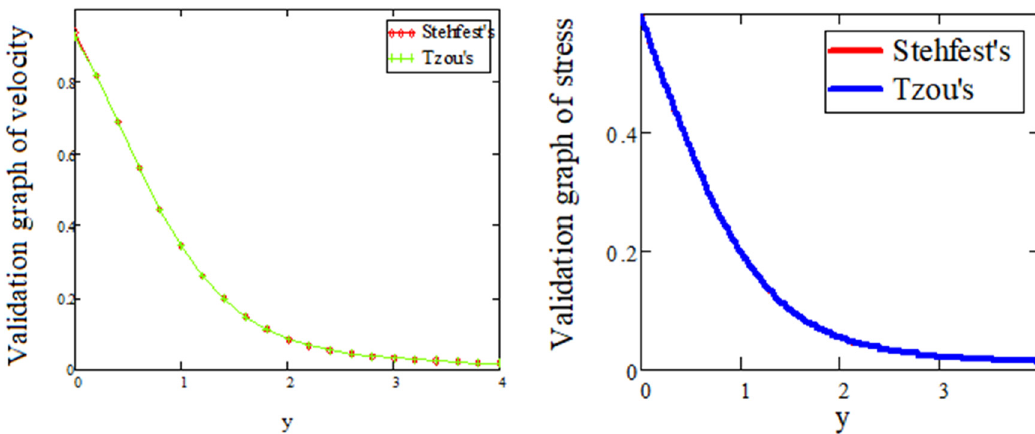
Figure 11: The validation of obtained results for velocity and stress function, with α 0.2 1 = and t 0.5 1 = .